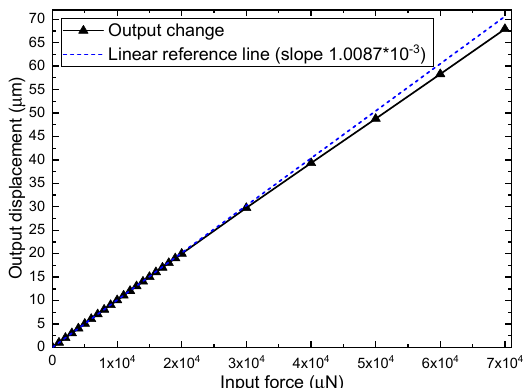
Figure 9. Input force vs. output displacement from 0 µ N to 7.0 × 10 4 µ N and linear reference line.